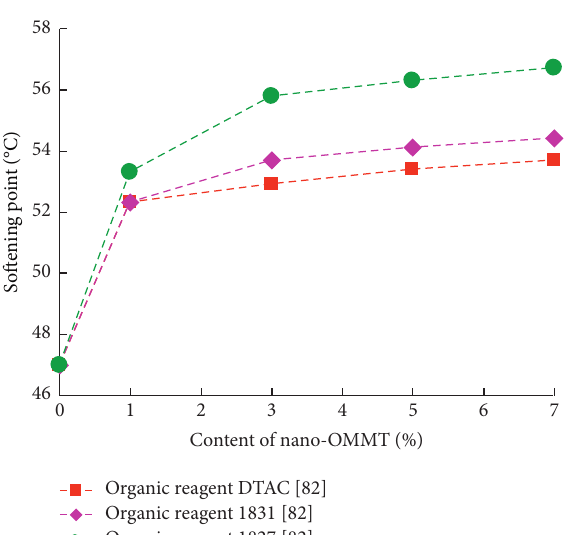
Figure 22: Dispersant effect on ductility.